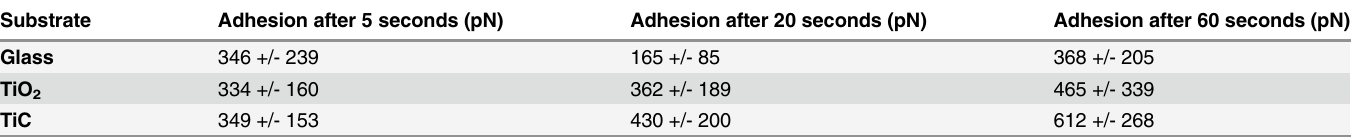
Table 3. Results of the SCFS experiments at different time